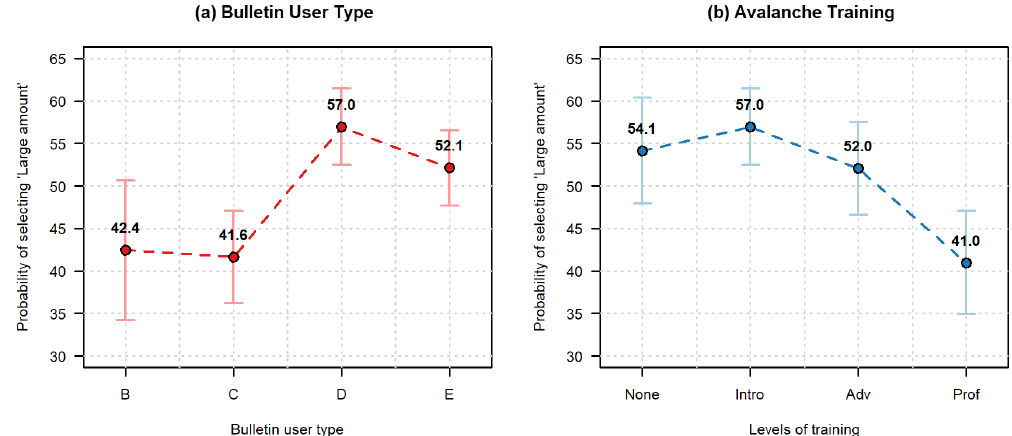
Figure 2. Estimated marginal probabilities for selecting a large amount for (a) different bulletin user types and (b) different avalanche training levels. Error bars represent 95% confidence intervals for probabilities calculated from the subsample for the particular parameter level. Variable levels for calculations of estimated marginal probabilities: bulletin user type – type D ( b only), avalanche awareness training – introductory ( a only), days in backcountry per winter – 11–20d, and country of residence –